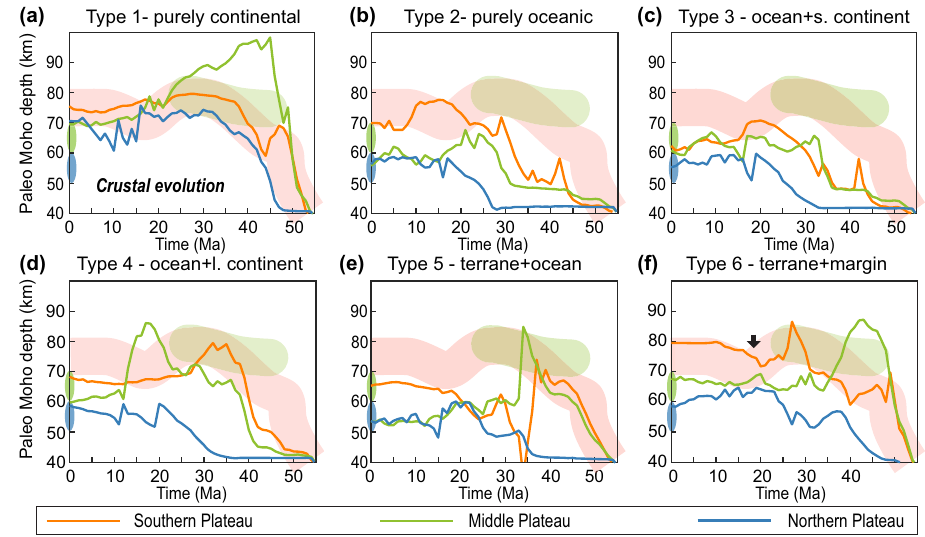
Fig. 8 | Crustal deformation in different numerical models. a – f Evolution of crustal thickness in Type 1 (Run 3, Figures S5c, S6c), Type 2 (Run 6, Figures S7b, S8b), Type 3 (Run 9, Figures S9c, S10c), Type 4 (Run 13, Figures S11c, S12c), Type 5 (Run 18, Figures S13d, S14d), and Type 6 (Run 23, Fig. 5) models, respectively. Background thick shadings are constraints from Figs. 2c and 2d. The horizontal